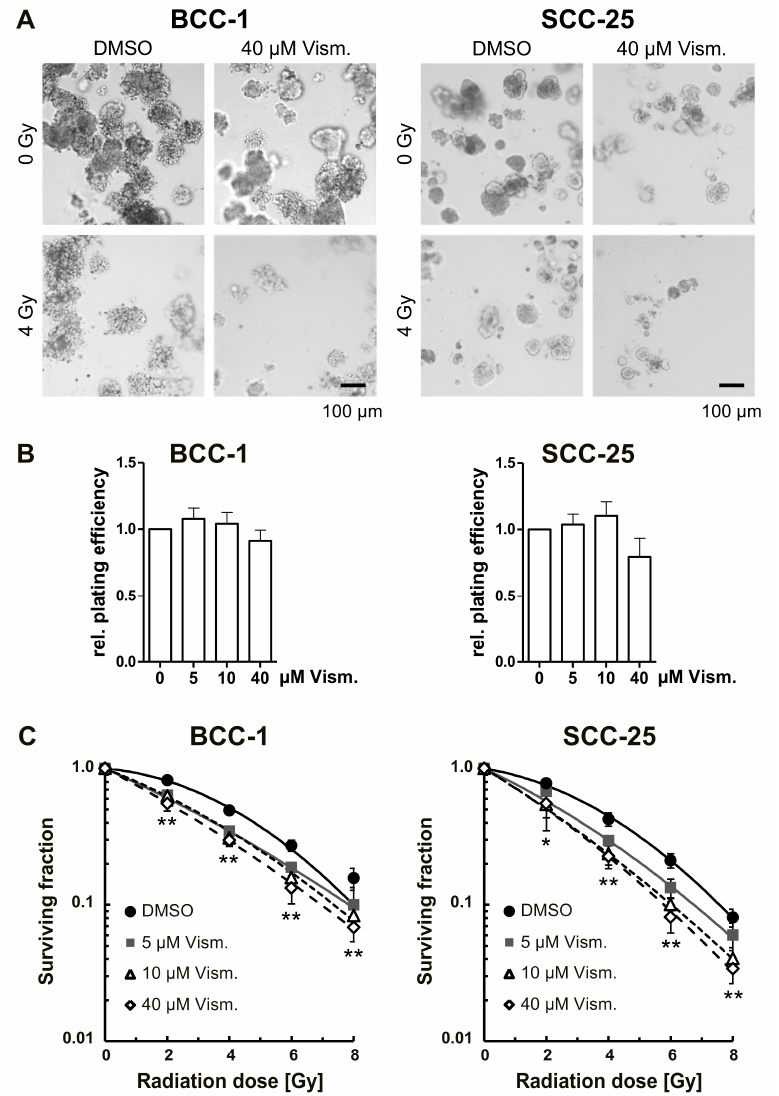
Figure 5. Vismodegib sensitizes basal and squamous cell carcinoma cells to ionizing radiation in a 3D clonogenic assay. BCC-1 and SCC-25 cells were plated as single cells in a three-dimensional (3D) laminin-rich extracellular matrix and were treated with vismodegib 24 h before irradiation with 0 to 8 Gy, single doses. ( A ) 7 days after plating, representative images of 3D grown colonies were acquired. Scale bar, 100 µm. ( B ) Colonies were counted microscopically from three independent experiments performed in triplicate. Basal plating efficiencies of cells treated with 5 to 40 µM vismodegib, are shown relative to DMSO-treated control cells. ( C ) Surviving fractions and radiation survival curves were calculated as described in the Materials and Methods section. Values represent means ± SD ( n = 3). * p < 0.05, ** p < 0.01; vismodegib-treated cells versus DMSO control ( t -test). Gy, Gray; Vism., vismodegib.